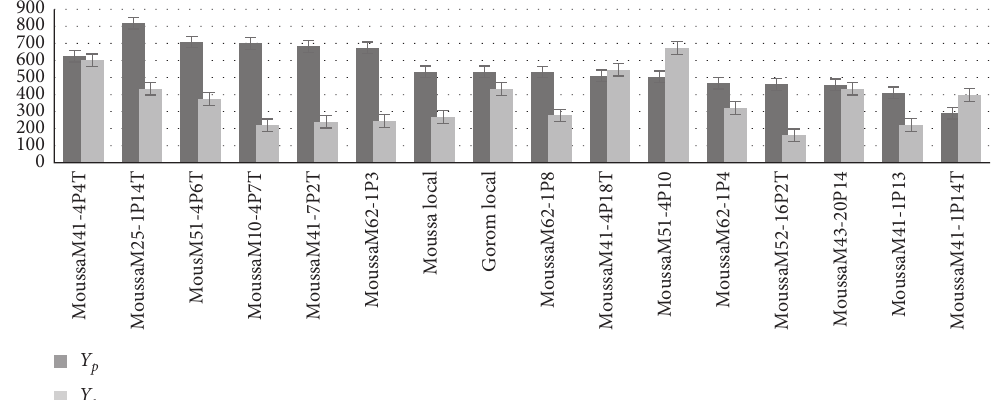
Figure 4: Yield performance of mutant and controls under nonstressed and stressed conditions. Y Y s : yield in stressed conditions (gram).